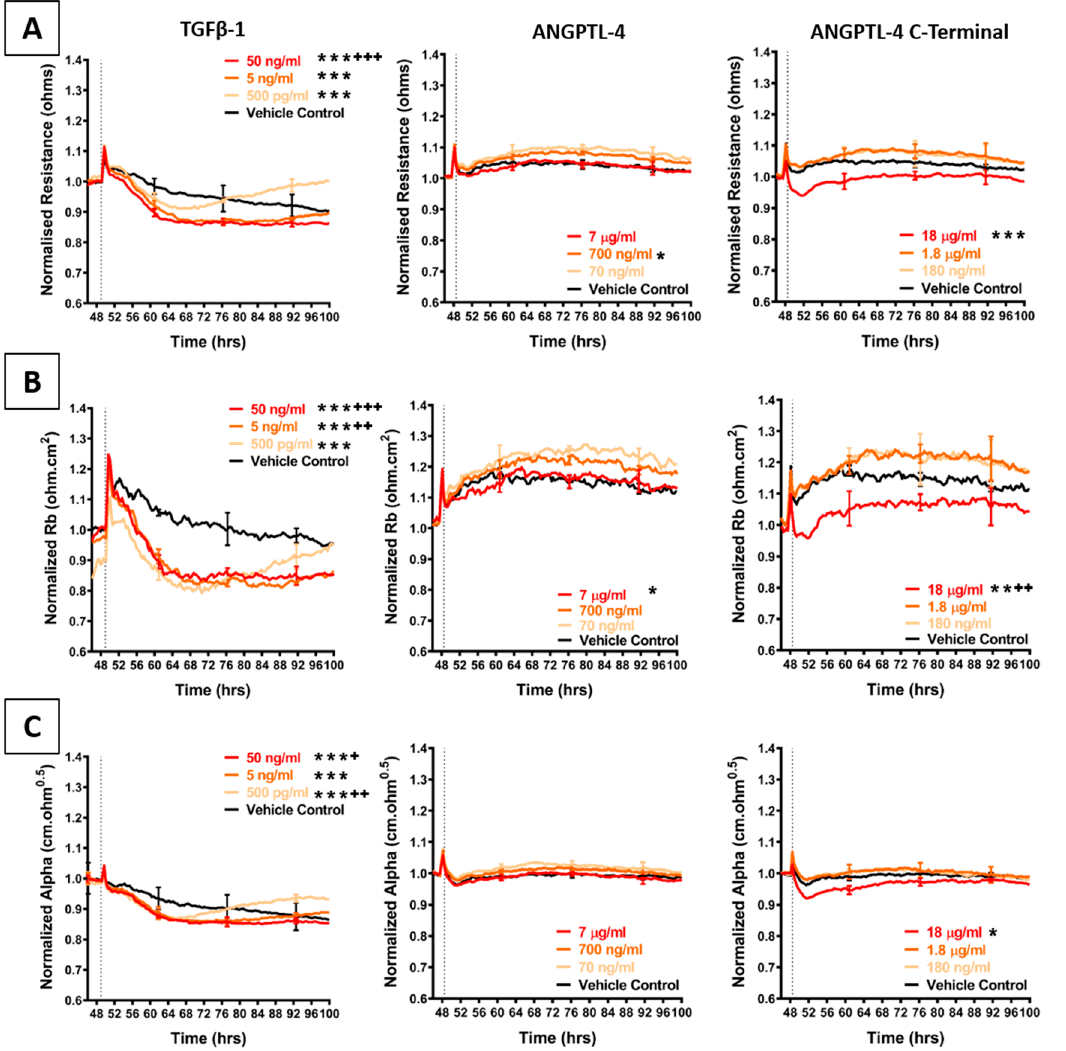
Figure 7. Effect of TGF β -1 and ANGPTL-4 on brain endothelial barrier resistance. ( A ): shows normalised unmodelled resistance (at 4000 Hz), ( B ): shows modelled Rb (paracellular resistance) and ( C ): shows modelled Alpha (basolateral resistance) of hCMVECs over time after addition of TGF β -1 and ANGPTL-4 (including the C-terminal fibrinogen like fragment of ANGPTL-4 alone). Recombinant proteins were added (dotted line) at top concentrations as recommended by the supplier and literature in a dilution series of 1:10. Data show the mean ± SD ( n = 3 wells) from one experiment, which is representative of three to four independent experiments. Values from three independent experiments were compared relative to their media control using two-way ANOVA with Tukey’s range test as detailed in Methods at 60 h (* p < 0.05, ** p < 0.01, *** p < 0.001) and 100 h: ( + p < 0.05, ++ p < 0.01, +++ p < 0.001).